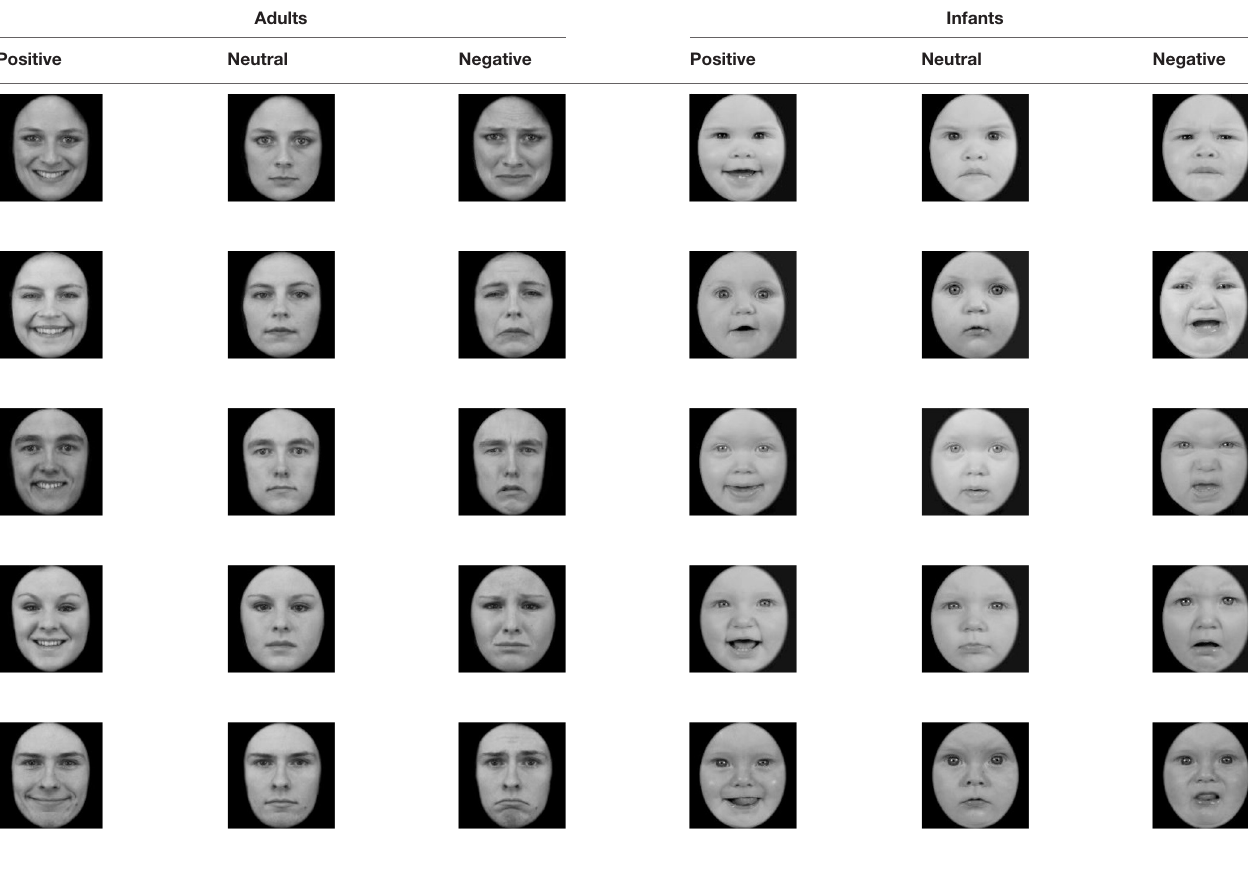
TABLE 1 | The 30 selected